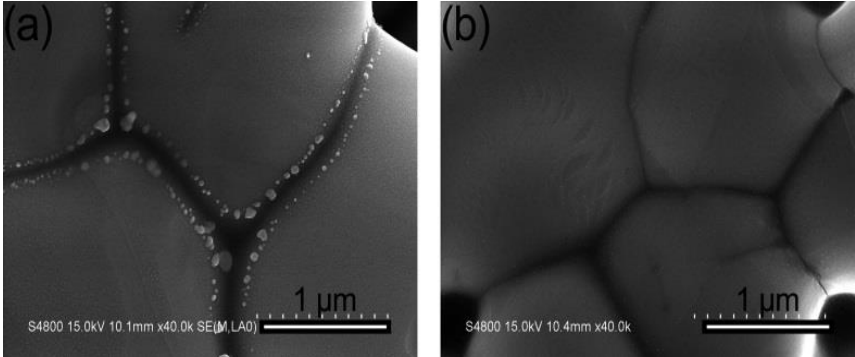
Figure 7. Surface morphology of sintered Ag electrode. (a) P-1 paste; (b) P-2 paste.